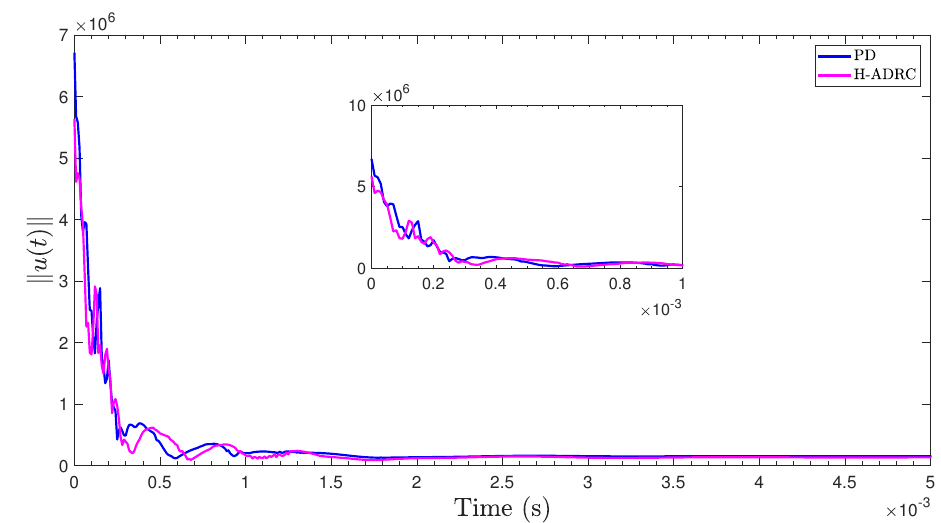
Figure 8. Euclidean norm of the control energy used with each control algorithm.